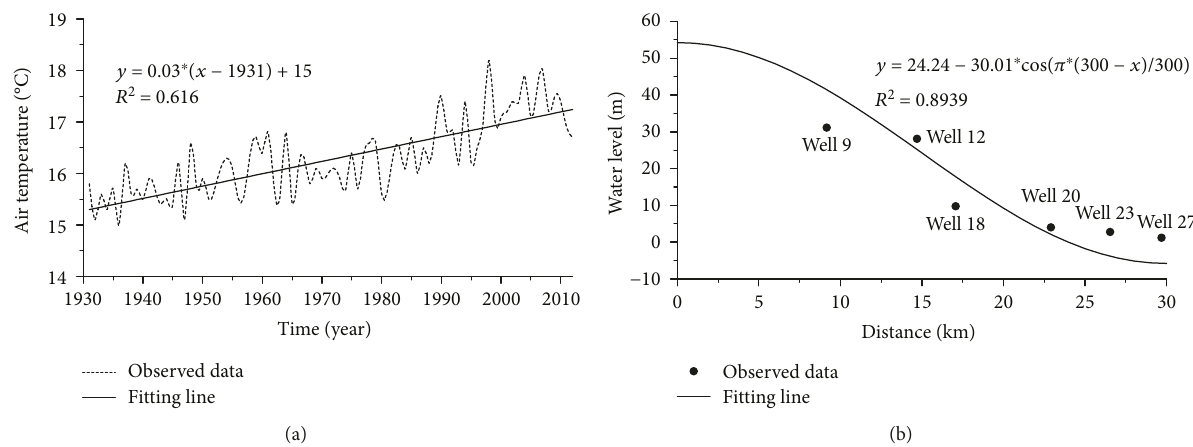
Figure 8: Observed data and fi tted curve for (a) air temperature between 1930 and 2012 and (b) water levels in observation wells along AA ’